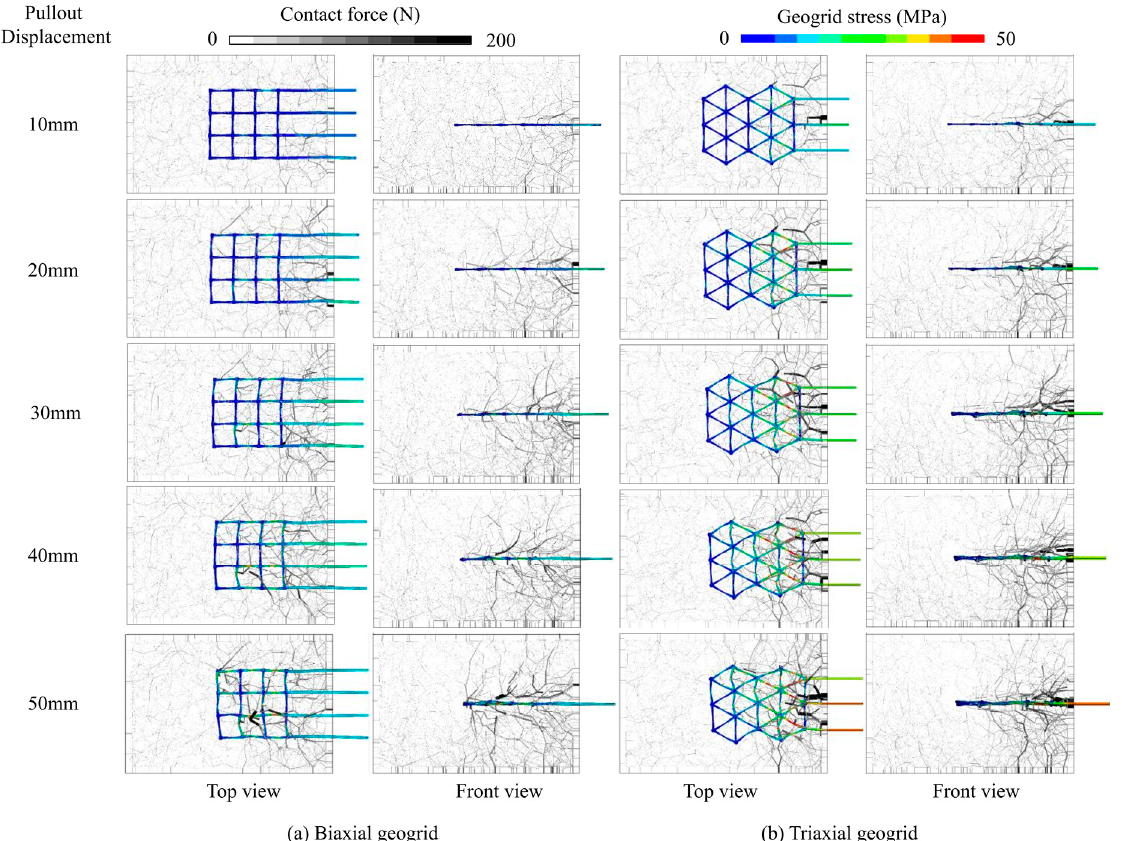
Figure 7. Contact force network and geogrid stress at different pullout displacement: ( a ) biaxial geogrid and ( b ) triaxial geogrid .